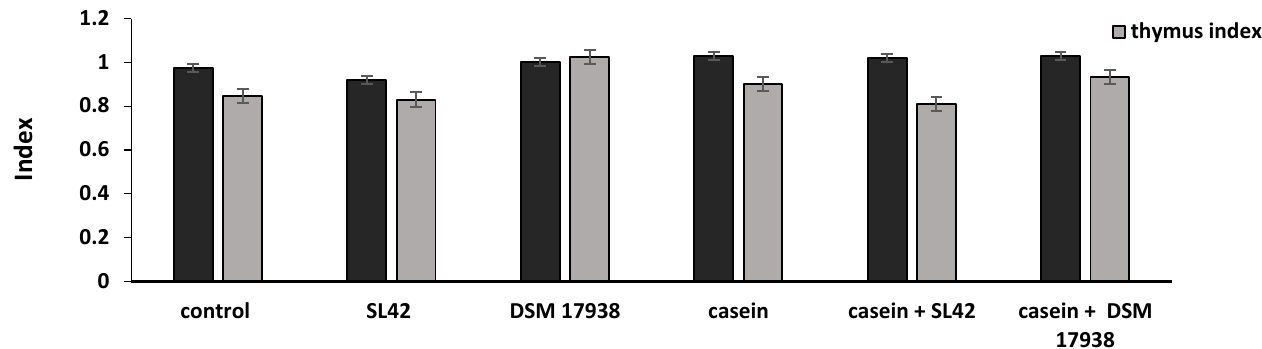
Figure 7. Effects of probiotic bacteria on the thymus and spleen indices of rats. Wistar rats were sensitized intragastrically by administration of casein without adjuvant. The rats were fed every other day with L. rhamnosus SL42 or L. reuteri DSM 17938 at 1 × 10 8 CFU/mL. The dose volume was 1 mL. The control group was fed with sterilized PBS solution. Thymus and spleen samples from each group were collected on the 59th day (day of sacrifice). The thymus and spleen indices were measured as the ratio of the thymus or spleen weight to rat body weight. Values are means ± SD (n = 8 rats/group). No significant differences were observed at p > 0.05. Control group receiving only PBS (control); nonsensitized group treated with SL42 strain (SL42); nonsensitized group treated with DSM 17938 strain (DSM 17938); casein-sensitized group (casein); casein-sensitized group treated with SL42 (casein + SL42); and casein-sensitized group treated with DSM 17938 strain (casein- + DSM 17938).